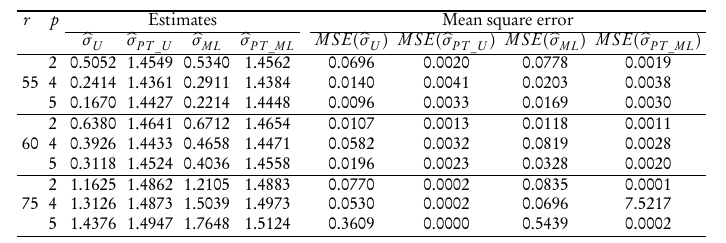
Estimates and corresponding mean square error of the parameter σ . The values are truncated to 4 decimal points, therefore few values in the column of mean square error being very small are mentioned as 0.0000.